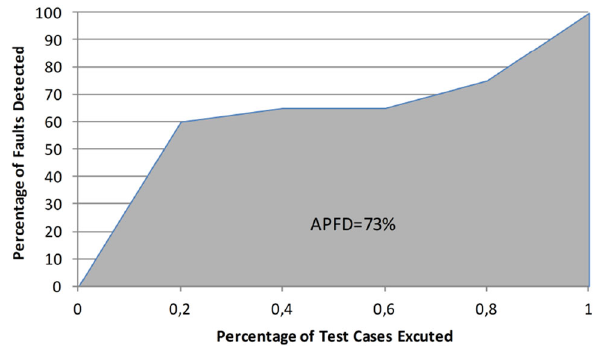
Fig. 6 APFD of local beam search for an arbitrary test suite